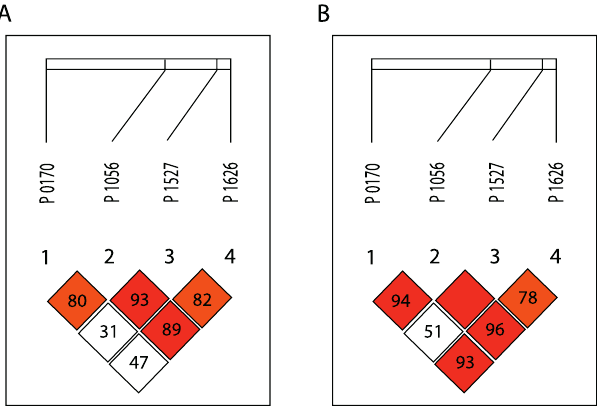
Figure 2. LD Analysis of Four Polymorphic Sites in the CD24 Gene The data from two cohorts of families are presented. Pairwise LD measure r 2 in the display was calculated for each of the six pairs of SNPs using data from three cohorts of families and the results are displayed in a tilted matrix. (A) Data from the OSU and MSGG families. (B) Data from the SLE families’ samples from Columbus Children’s Hospital. Complete LD was observed between 1056 and 1527/1626 in the SLE family sample cohort between 1056 and 1527.